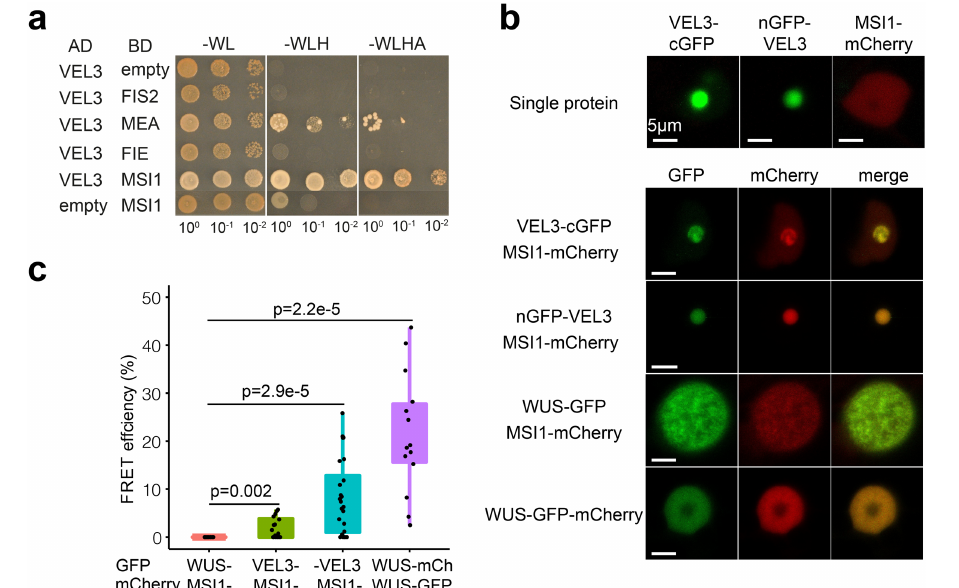
Fig. 3 | VEL3 interacts with MSI1 and can direct MSI1 to the nucleolus. a Yeast 2-hybrid assays show a robust interaction with the PRC2 component MSI1. MEA shows autoactivation in our assays (Supplementary Fig. 3e). b VEL3 expression affects the sub-nuclear localization of MSI1. Nuclear images of Nicotiana cells expressing VEL3 fused at either the N- or C-terminus to GFP with cells expressing either VEL3 alone, MSI1 alone or VEL3 and MSI1. Co-expression of MSI1 with the control nuclear protein WUSCHEL (WUS) is shown for comparison. VEL3-: VEL3-